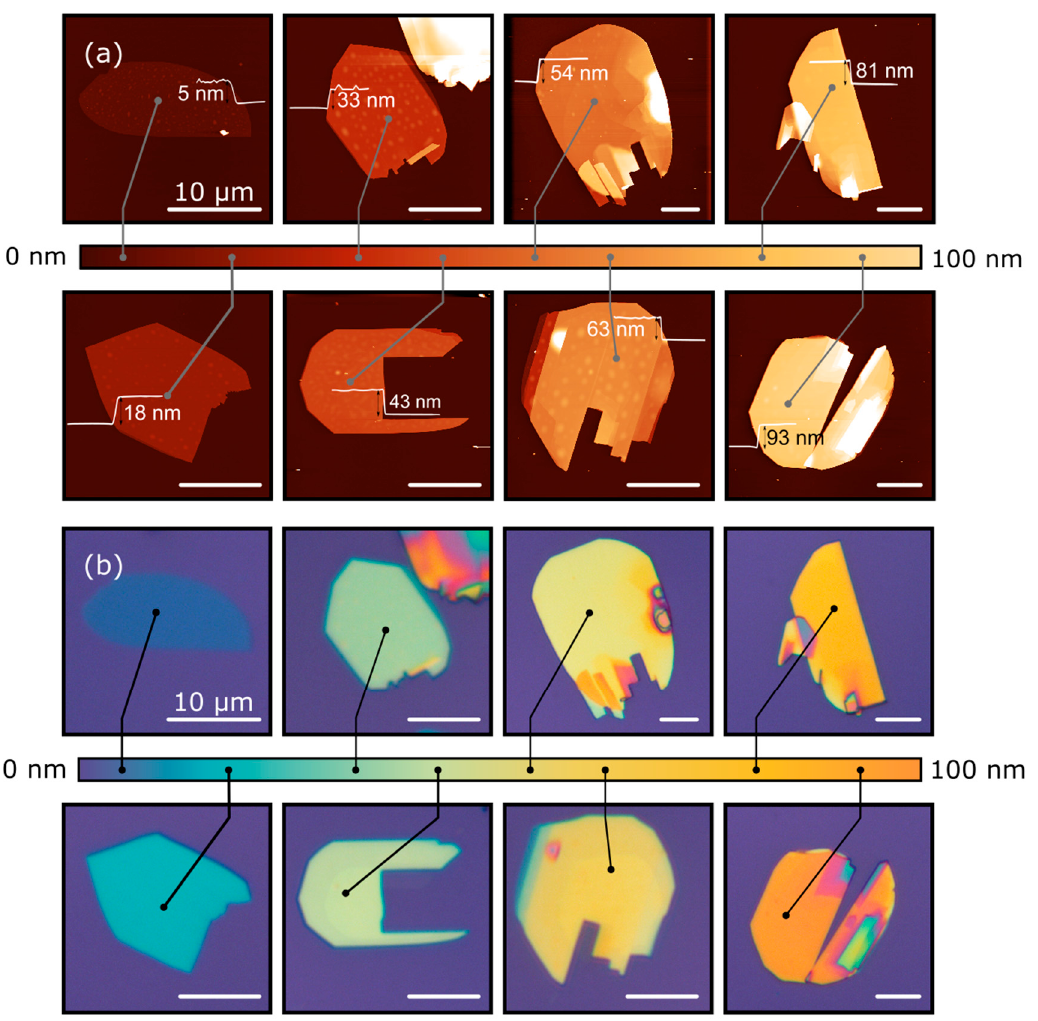
Figure 1. Thickness dependent apparent color of MoO 3 flakes. ( a ) AFM measurements of the exfoliated flakes with different thickness placed on a 297 nm SiO 2 /Si substrate. ( b ) Optical images of the flakes and a colorbar with the apparent color of flakes with thickness from 5 nm up to 93 nm (from 7 to ~130 layers). Scale bars: 10 µm.